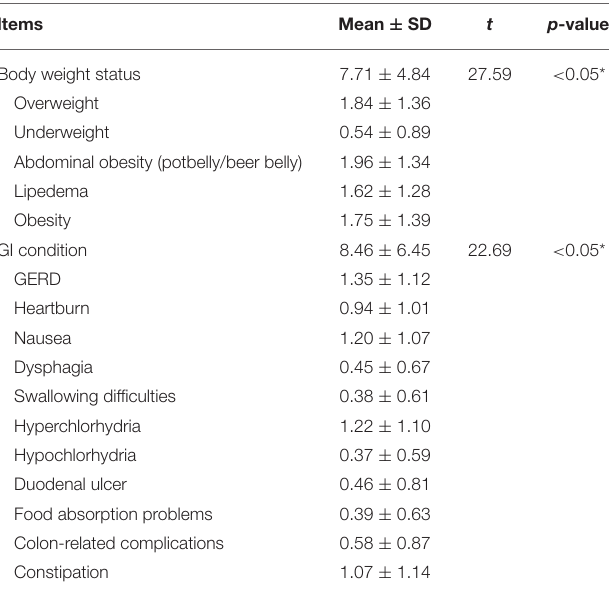
TABLE 3 | Predictors of GI health of the participants ( N =